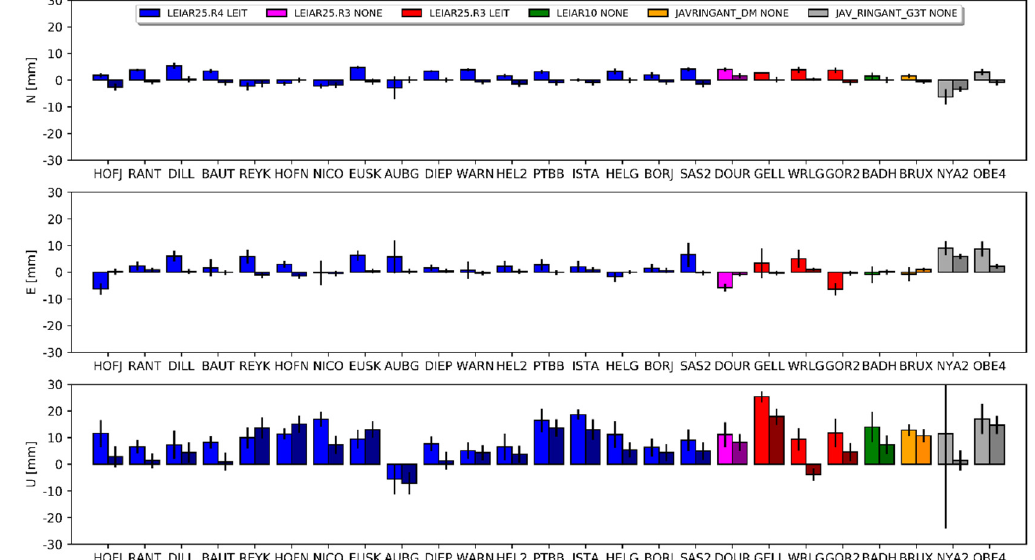
Figure 7. Coordinate differences between the E1 and G1 solutions and their standard deviations. Darker columns refer to the DD approach. Values are presented in Table A3.